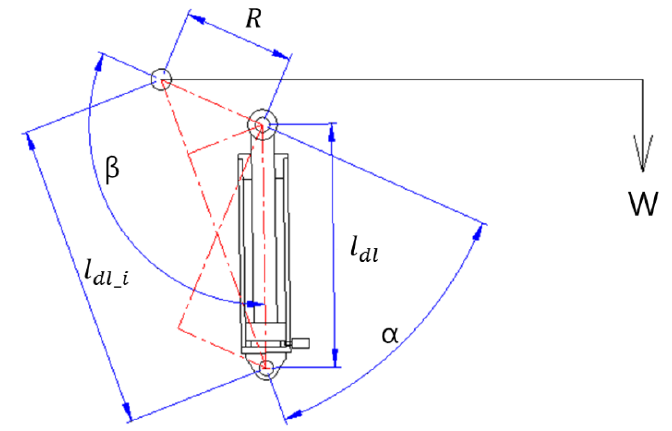
Figure 3. Dimensions of the derrick cylinder moment.